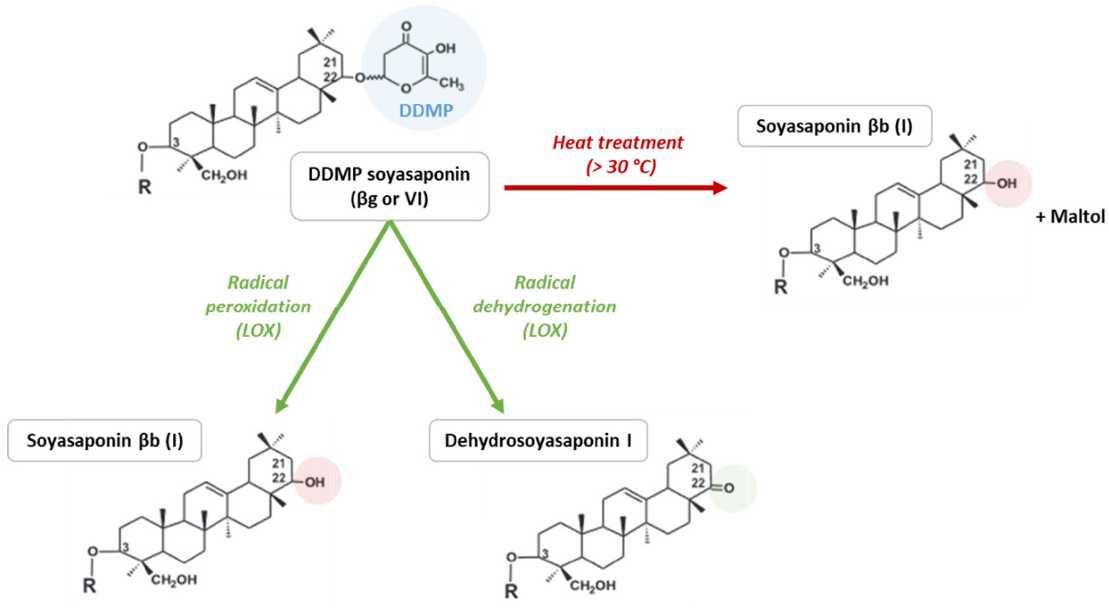
Figure 3. Degradation of DDMP soyasaponin into soyasaponin βb and dehydrosoyasaponin I through heat treatment and enzymatic reactions (adapted from [78]). LOX: lipoxygenase; R: glucuronic acid-galactose-rhamnose.